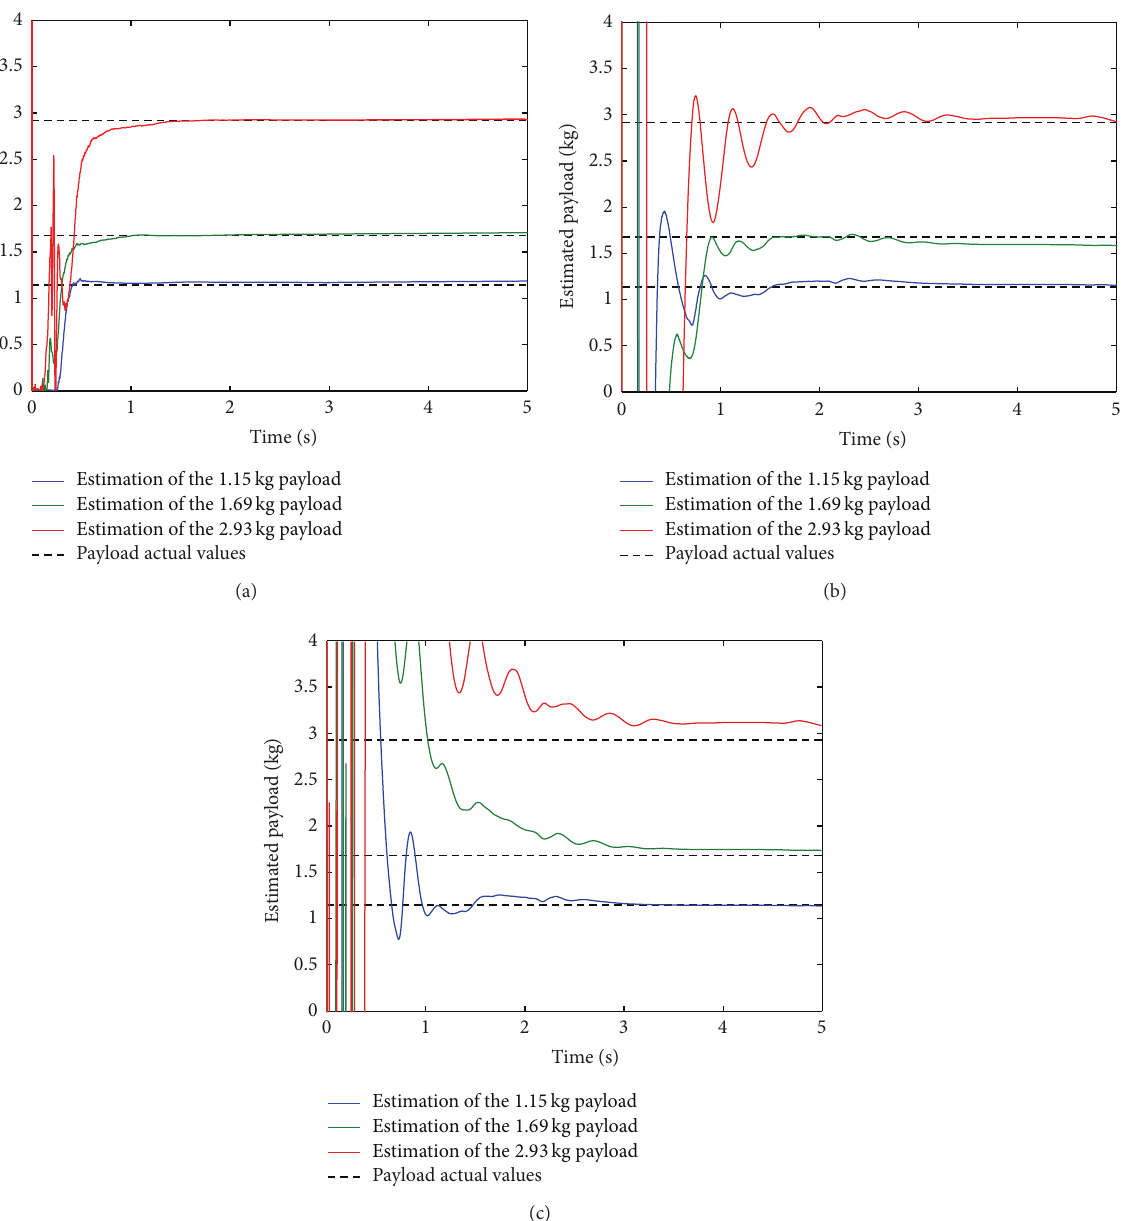
Figure 9: Experiment type 2: (a) algebraic identifier, (b) least square fitting, and (c) least square fitting with